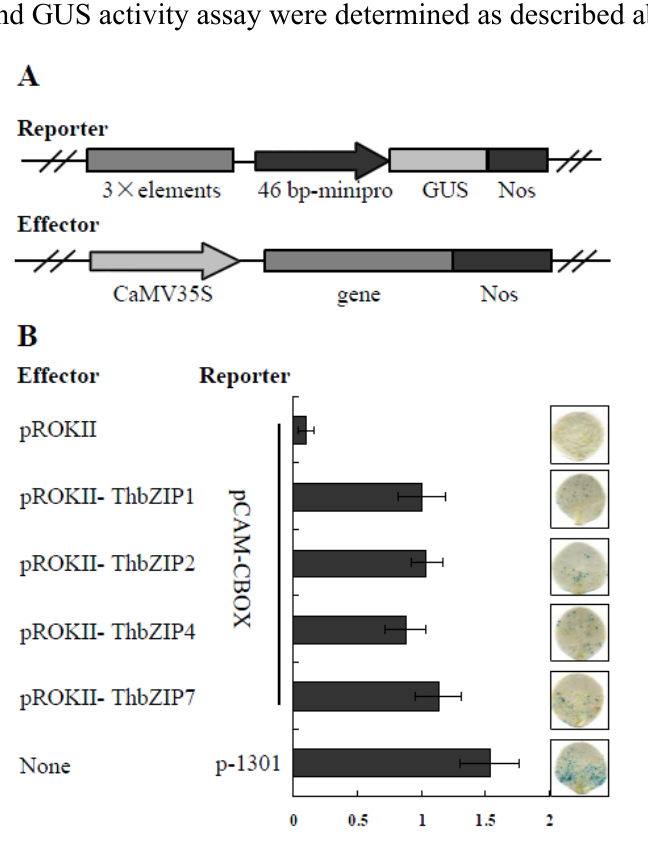
Figure 2. Transactivation potential of selected ThbZIP transcription factors. ( A ) To further verify these interactions, the three tandem copies of the C-box were fused to the minimal 35S promoter ( − 46 to +1) and the resultant fusion was cloned into pCAMBIA1301 to substitute its 35S promoter driving GUS ( β -glucuronidase) (constructs containing the C-box were named pCAM-C). The effector vector was constructed by cloning the full ORFs (open reading frames) of ThbZIP genes into pROKII under the drive of the 35S promoter (pROKII- ThbZIPs ) (see Table S1 for the primers used). Both the reporter and effector vectors were co-transformed into tobacco leaves using particle bombardment; ( B ) GUS staining and GUS activity assay were determined as described